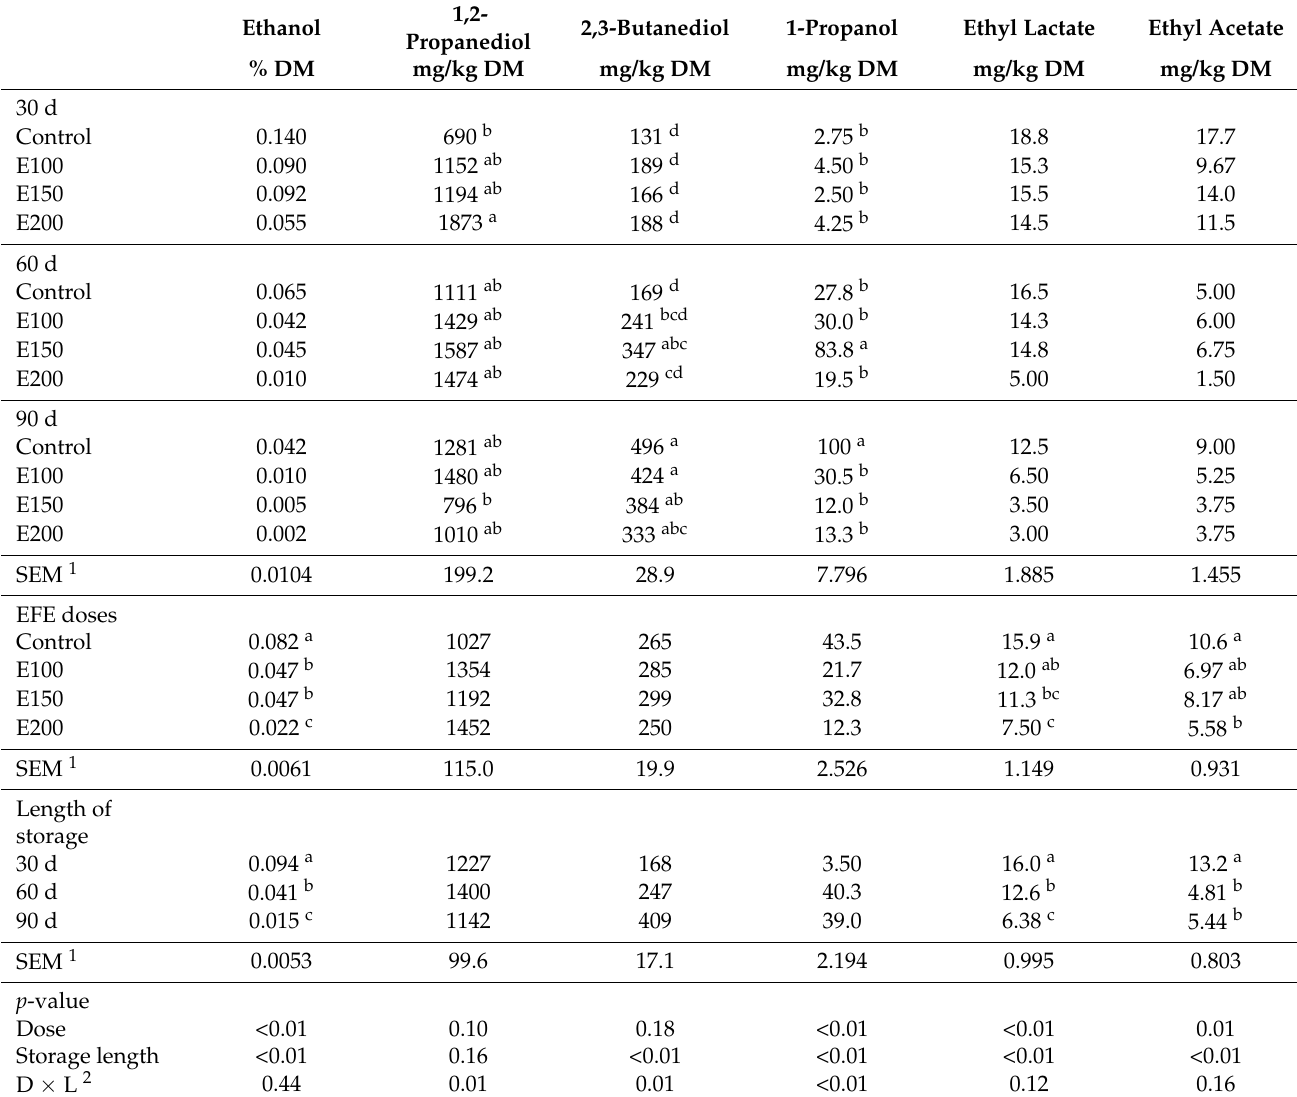
Table 3. Concentrations of alcohols and esters (DM basis) in maize silages treated with exogenous fibrolytic enzymes (EFEs) at 0, 100, 150 and 200 g/ ton of DM ensiled for 30, 60 and 90 days.